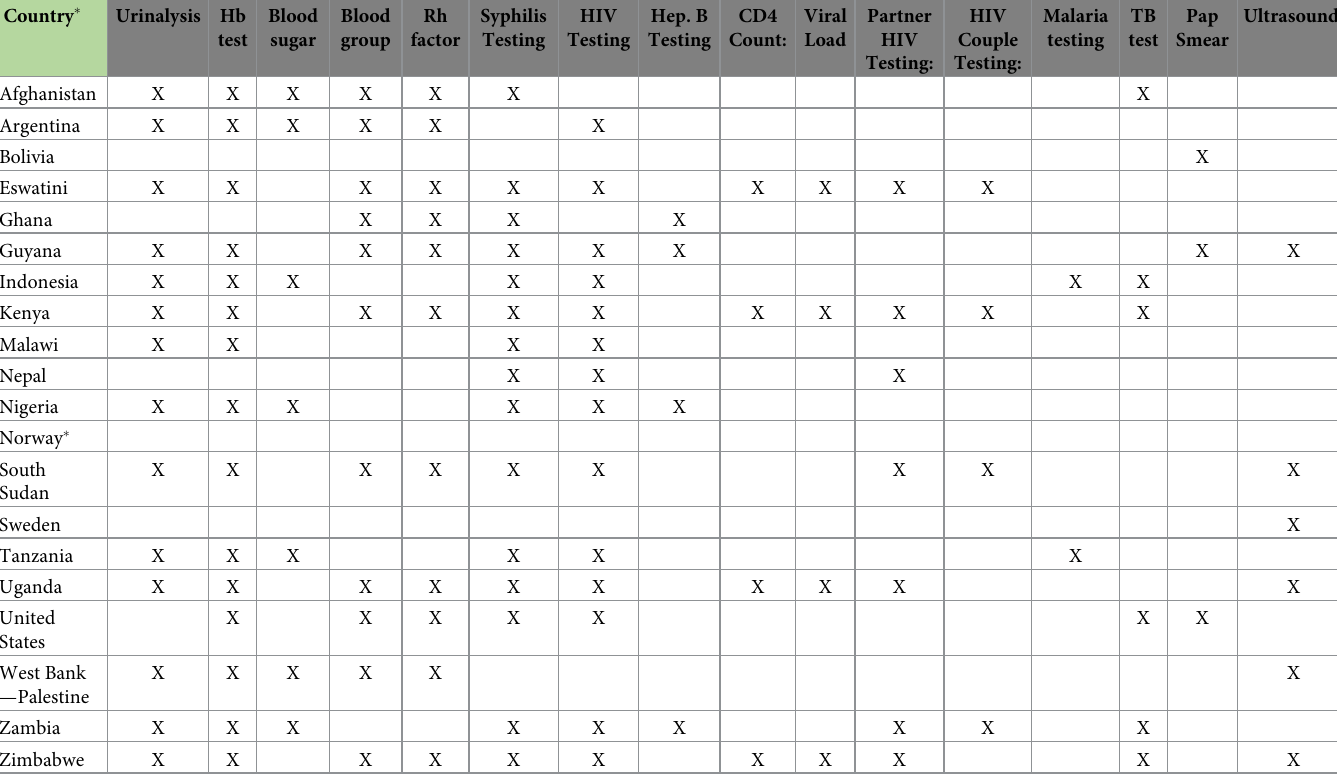
Table 4. Screening and testing performed during antenatal care